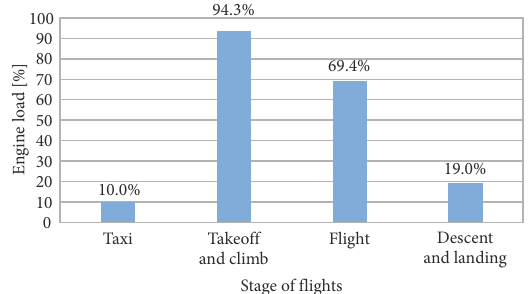
Figure 8. Mean engine load over the given stages for flights 1, 2,